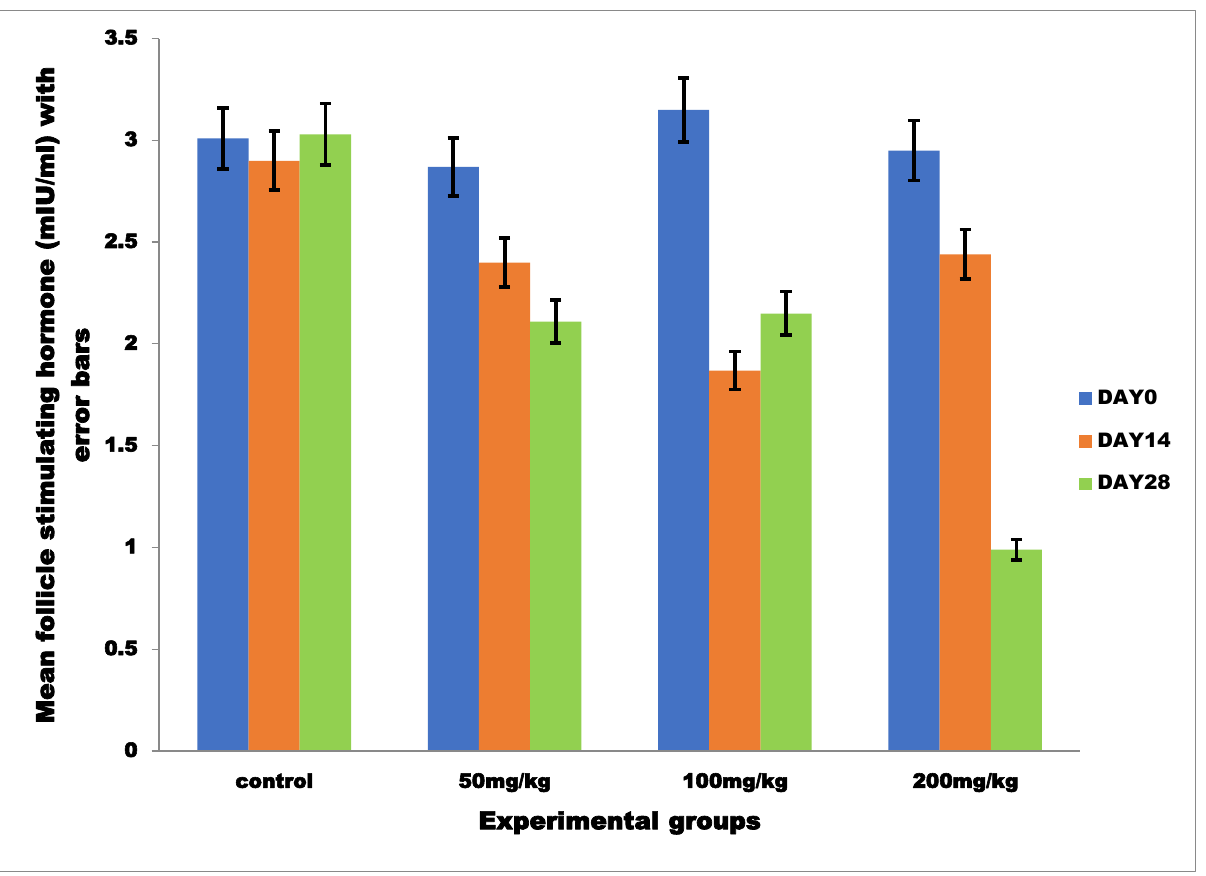
Figure 5. Mean serum FSH levels in female albino rats exposed to graded doses of MSEAI at different time points.